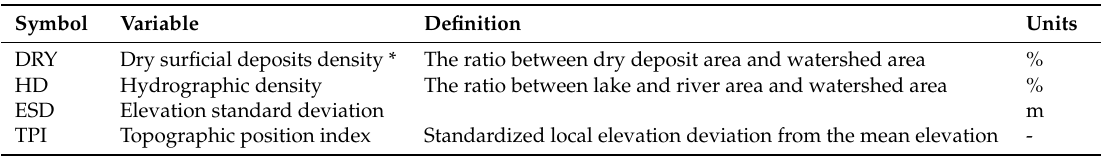
Table 1. Definition of explanatory (predictor) variables ( p in the Cox proportional hazard model, see Equation